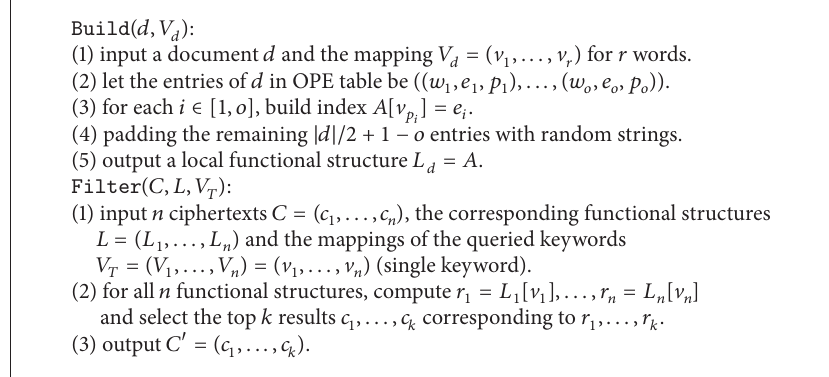
Algorithm 8: Ranked keyword query